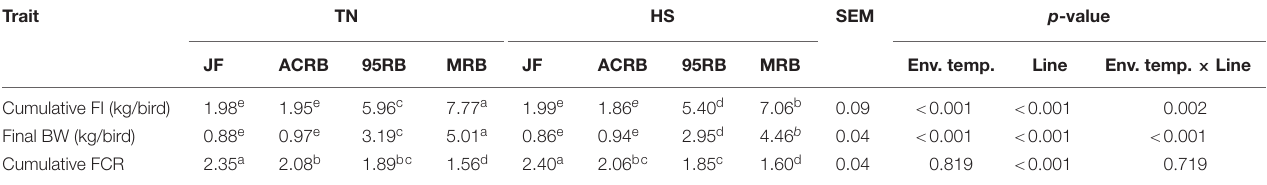
TABLE 3 | Effect of cyclic heat stress on cumulative feed intake (FI), final body weight (BW), and cumulative feed conversion ratio (FCR) ( n = 3 replicate/group). Trait TN